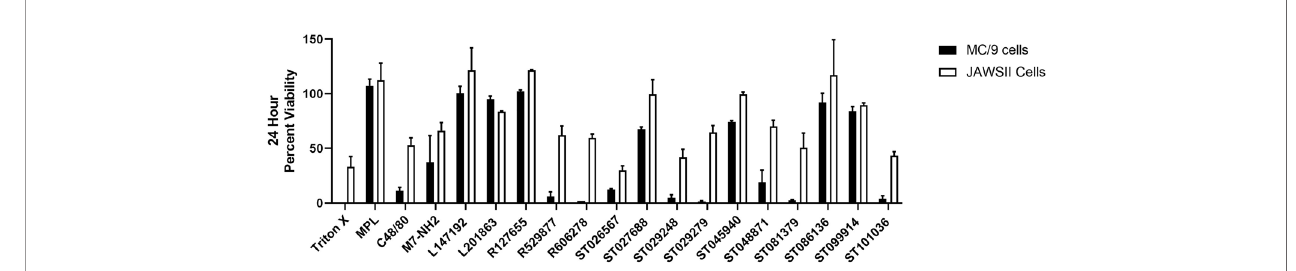
FIGURE 2 | Small molecule mast cell activators induce unique cytotoxicity pro fi les in mouse innate immune cells. Mouse MC/9 mast cells or JAWSII dendritic cells were incubated in the presence of the small molecule mast cell activators (100 m M) or positive control vaccine adjuvants MPL, C48/80, or M7 for 24 hours. Cell viability was measured using a colorimetric MTS assay.